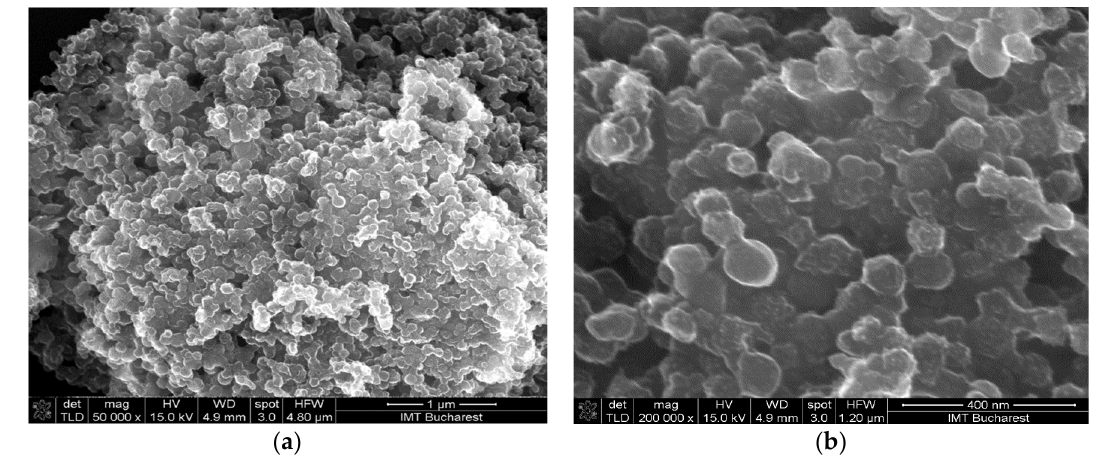
Figure 6. Scanning electron micrographs of the GO/CNHox/PVP at 1:1:1 w/w/w ratio: ( a ) ×50,000 magnification; ( b ) ×200,000 magnification.